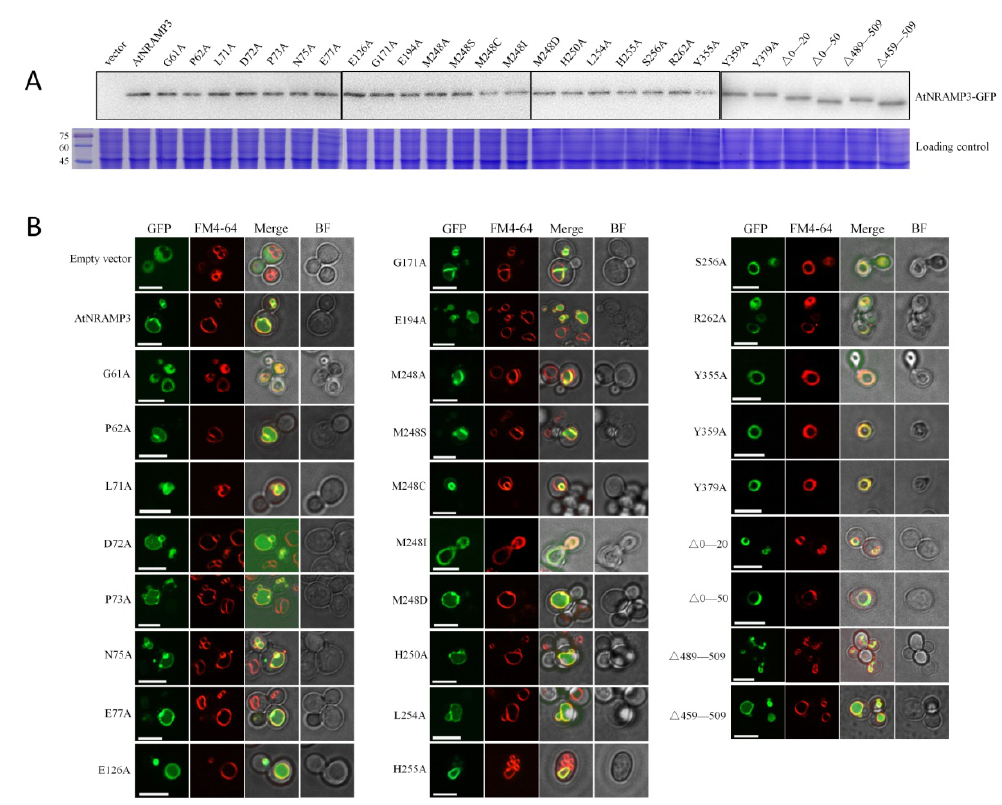
Figure 6. Expression and subcellular localization of AtNRAMP3 mutant proteins. ( A ) Western blot analysis of crude membrane fraction prepared from the BY4741 cells expressing wild-type and mutant variants of AtNRAMP3-GFP using an anti-GFP antibody. Sodium dodecyl sulfate polyacrylamide gel electrophoresis (SDS-PAGE) was used as a loading control. ( B ) C-terminal GFP fusion protein expressed in the S. cerevisiae strain BY4741. Cells were visualized 24 h after induction. From left to right, GFP fluorescence, FM4-64, merged images and bright-field. Scale bar: 5 μm.